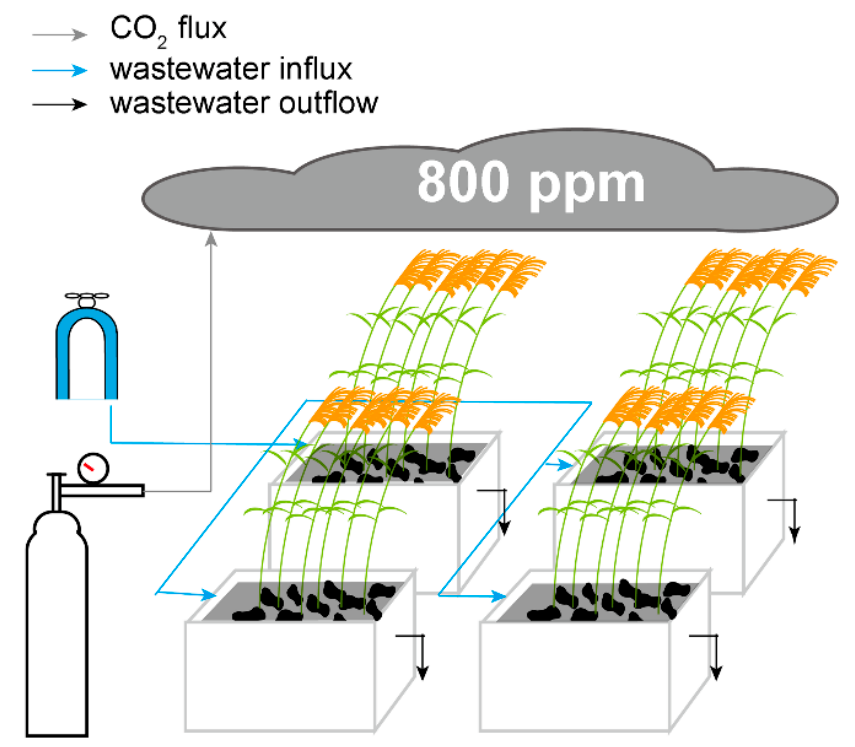
Figure 1. A schematic diagram of the CW system.